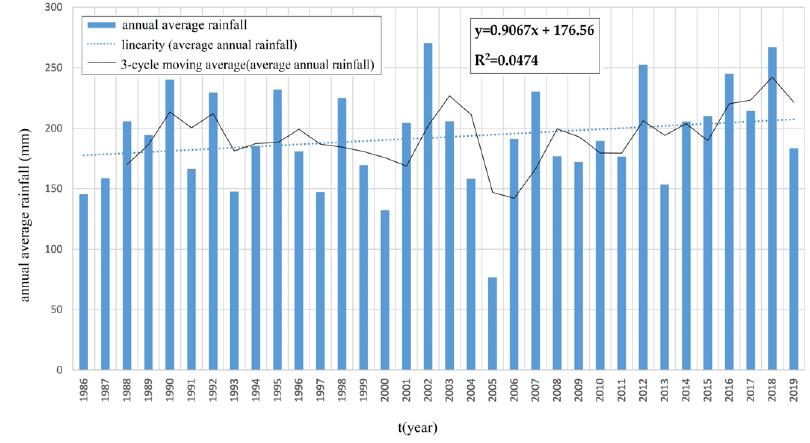
Figure 11. Changes in average annual precipitation in the Yellow Irrigation District.